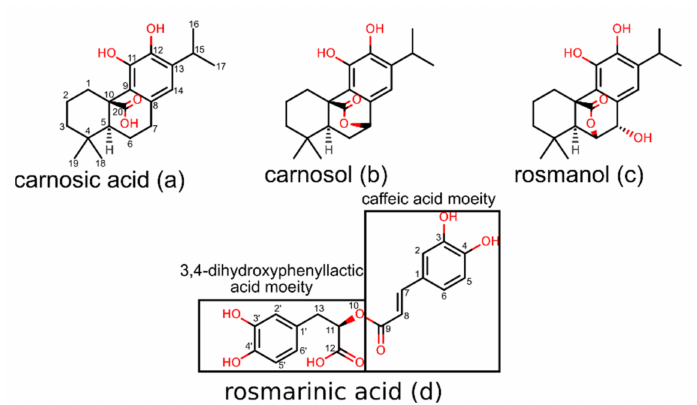
Figure 1. Molecular structures and atom numbering of compounds investigated in the inverse dock- ing study ( a ) molecular structure of carnosic acid, ( b ) carnosol, ( c ) rosmanol, and ( d ) rosmarinic acid. Rosmarinic acid represents an ester of caffeic acid and 3,4-dihydroxyphenyllactic acid [34]. The structure contains two electroactive catechol moieties that can neutralize free radicals through the electron/proton donor mechanism. Examination of the